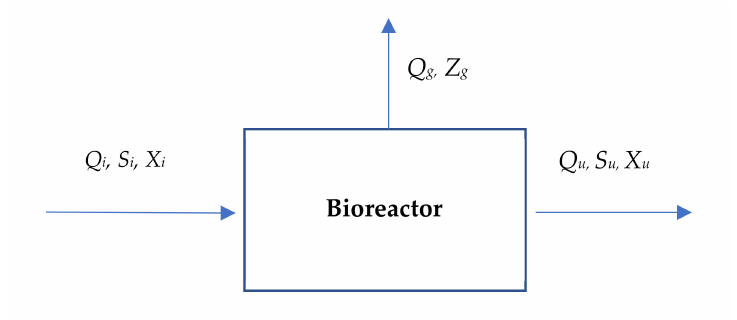
Figure 1. Model scheme to simulate an anaerobic bioreactor. where Q in , Q u , and Q g are the flowrates of the input and output of the sludge and flowrate of the produced biogas (L.d − 1 ),